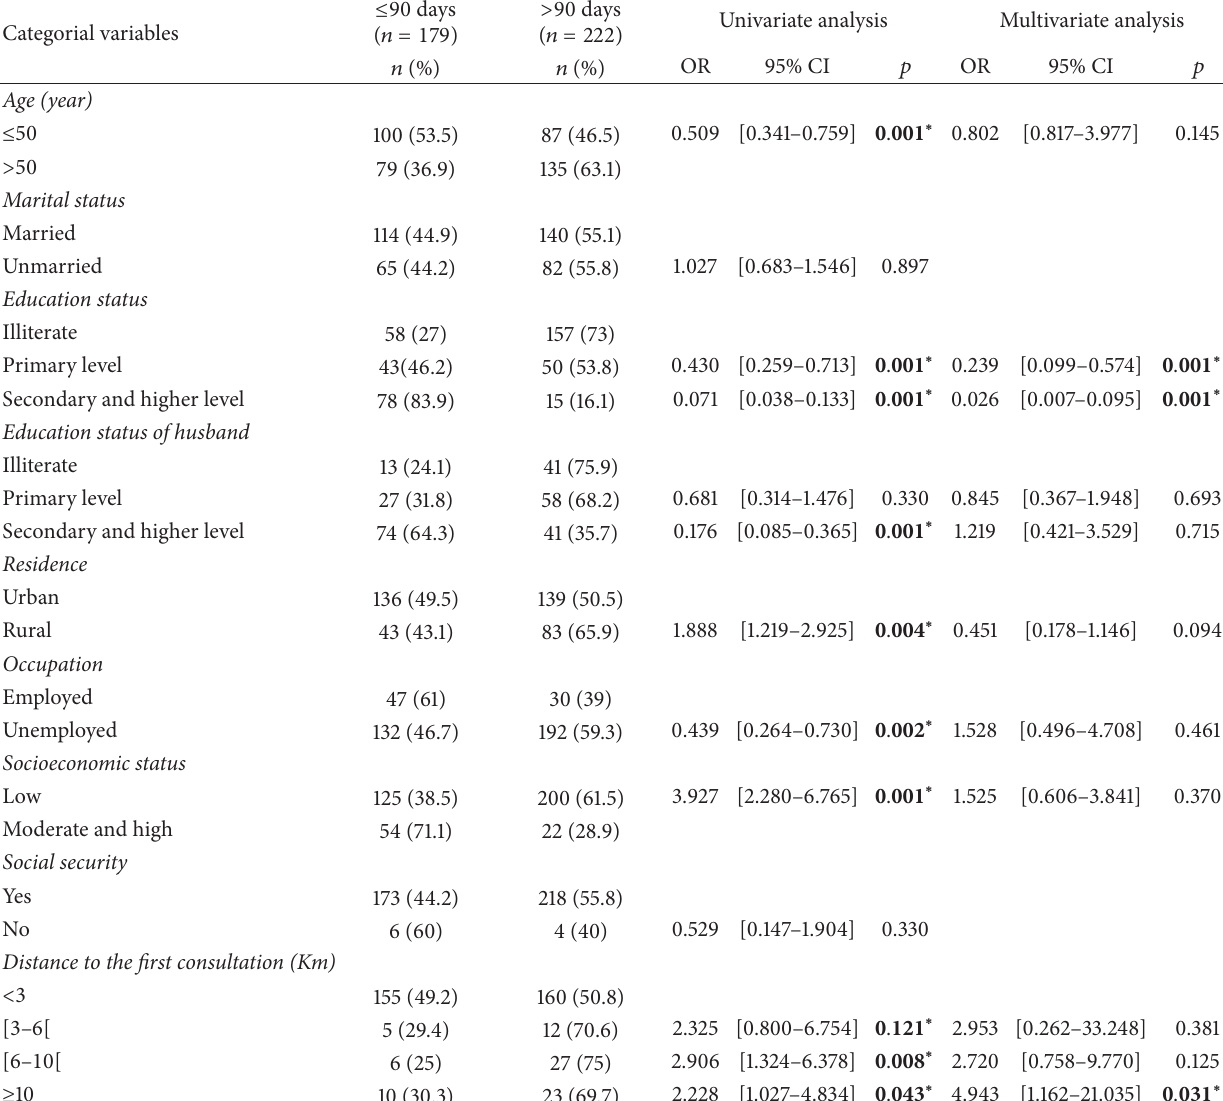
Table 3: Associations between delayed reporting demographic and socioeconomic